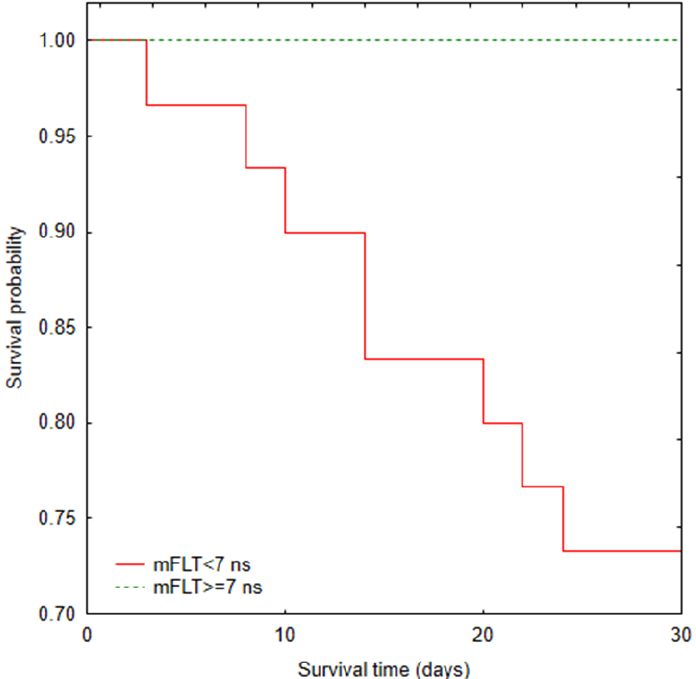
Figure 4. Kaplan–Meier plot for probability of survival for mFLT. Log-rank test p = 0.001.